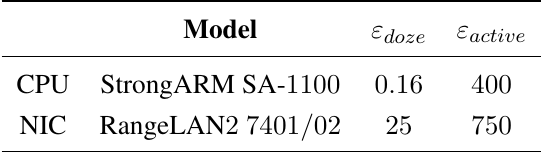
Table 1. Energy consumption of a client (in mW/s